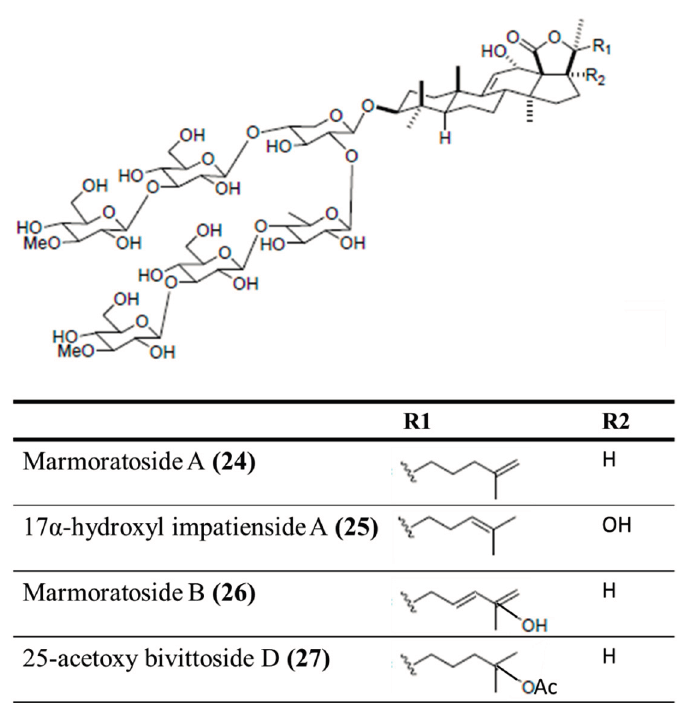
Figure 7. Marmoratoside A ( 24 ), 17 α -hydroxy impatienside A ( 25 ), marmoratoside B ( 26 ), and 25-acetoxy bivittoside D ( 27 ), isolated from sea cucumber Bohadschia marmorata [61]. 3.4.3. Scabraside A, Echinoidea A, and Holothurin A1 Three antifungal triterpene glycosides, scabraside A ( 28 ), echinoidea A ( 29 ), and holothurin A1 ( 30 ), were isolated from Holothuria scabra (Figure 8) [62]. These triterpenoid glycosides